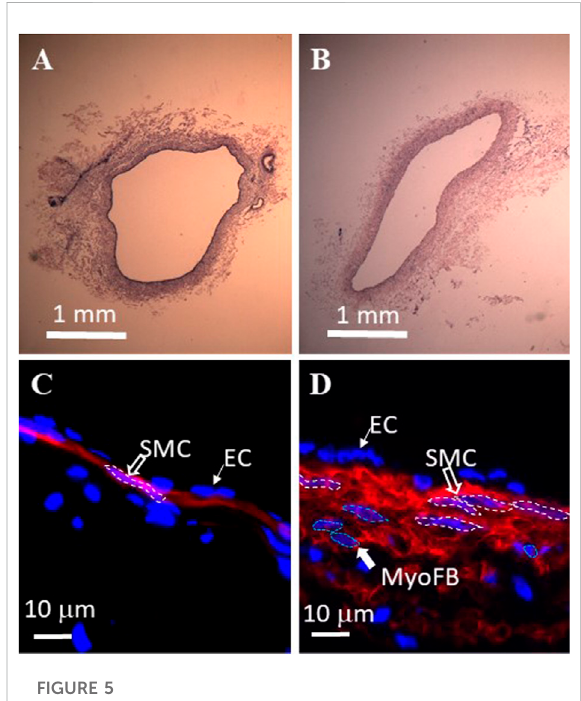
FIGURE 5 Histological analysis of swine thoracic duct for control and 28 days post-TR surgery. (A) Control in HE staining. (B) 28 days post-TR surgery in HE staining. (C) Immuno- fl orescence image of control. Red: α − actin. Blue: nuclei. SMC: smooth muscle cell. EC: endothelial cell. (D) Immuno- fl orescence image of 28 days post TR surgery. Red: α − actin. Blue: nuclei. MyoFB: myo fi broblast.